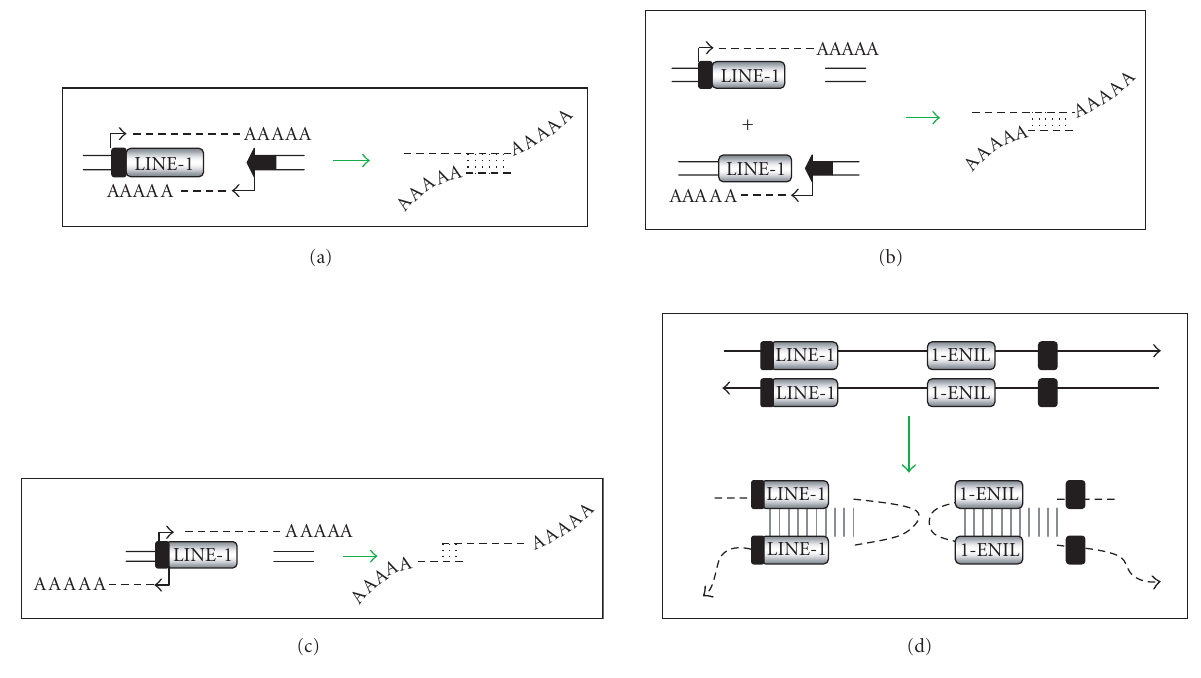
Figure 1: Generation of L1 dsRNA . L1 dsRNA could arise from di ff erent transcripts (shown in Figures 1(a), 1(b), and 1(c)) or from the same transcript (shown in Figure 1(d)). (a) An L1 transcript originates from the internal 5 (cid:2) UTR promoter, producing a sense-strand RNA. Neighboring the same element, an antisense-oriented heterologous promoter produces a read-through transcript that includes antisense L1 RNA. (b) An L1 is transcribed producing sense RNA and another L1 insertion, elsewhere in the genome, is transcribed o ff of a heterologous promoter yielding an antisense RNA. (c) An L1 is transcribed o ff of its 5 (cid:2) UTR producing a sense transcript, while antisense promoter activity of the 5 (cid:2) UTR produces an antisense transcript. (d) If an L1 inserts near another L1 sequence in the genome, it may be possible to create a hairpin. The figure shows two full-length L1 sequences facing each other, although it should be noted that hairpins could also form between truncated L1 copies that face each other, as long as there is a transcript that extends between the copies. DNA strands are shown with solid lines and RNA with dashed lines. In the scenario depicted, transcripts o ff of either DNA strand extending through the two L1 sequences will give rise to self-complementary regions: the forward facing L1 and the reverse complementary sequence of L1 on the same RNA strand can base pair, forming hairpins (dashed vertical lines) with stretches of